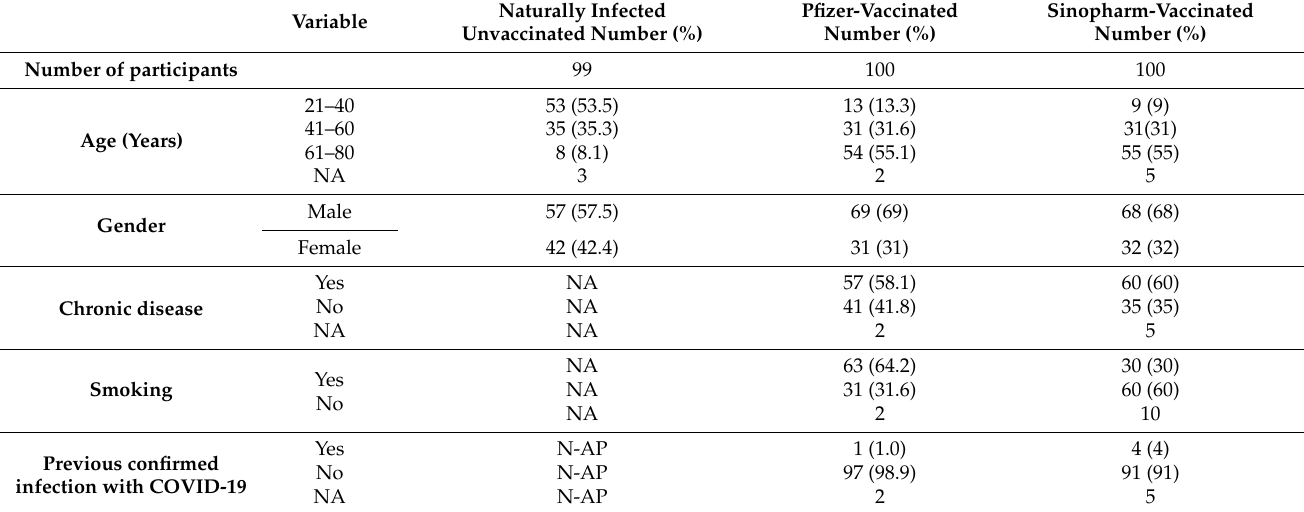
Table 1. Demographic and clinical data of COVID-19 patients ( n = 99), Pfizer-vaccinated recipients ( n = 100), and Sinopharm-vaccinated recipients ( n =